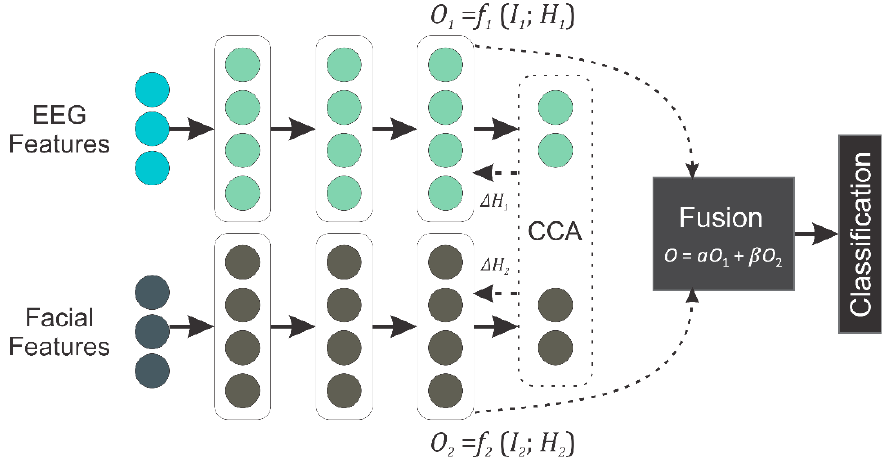
Figure 5. DCCA method used for fusion of EEG and facial video clip features. Table 2. Selected hyperparameters and corresponding range for the evaluation of optimal values to design a 1D neural network for